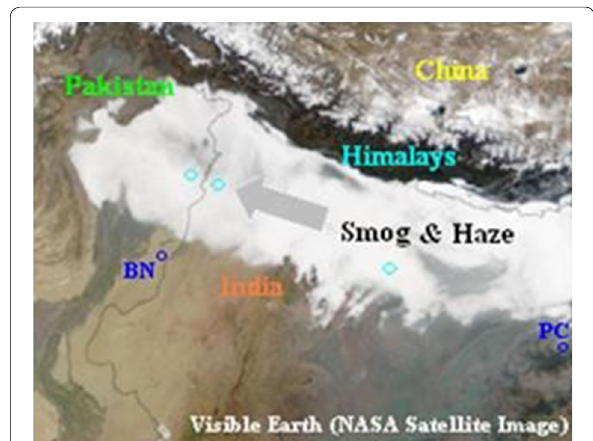
Fig. 6 Flow of smog and haze from India to Pakistan